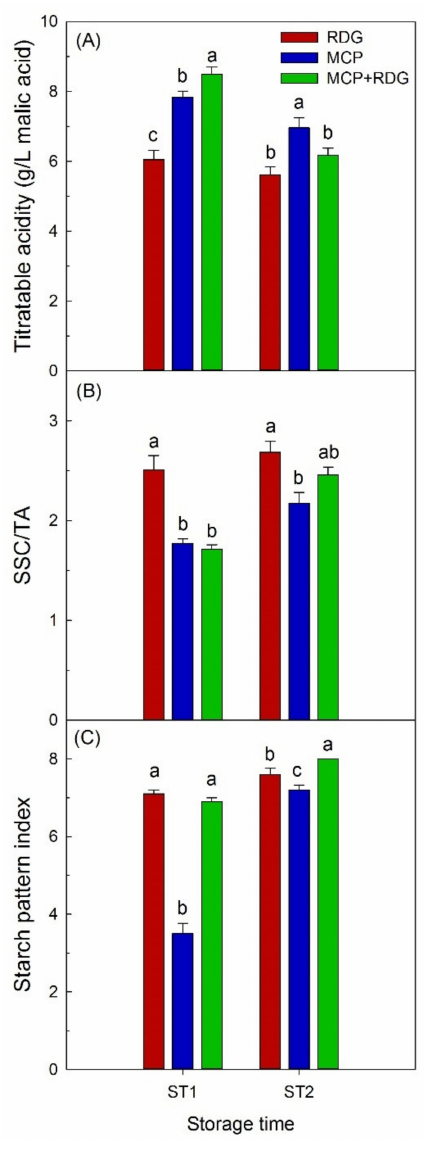
Figure 2. Titratable acidity ( A ), the SSC/TA ( B ) and starch pattern index ( C ) measured at two storage times (ST1 and ST2) for apples exposed to the three postharvest management treatments, RDG (standard reddening process), MCP (apples treated with 1-MCP, without the reddening process) and MCP + RDG (apples treated with 1-MCP and with the reddening process). For each sampling time, different letters indicate a statistically different value ( p ≤